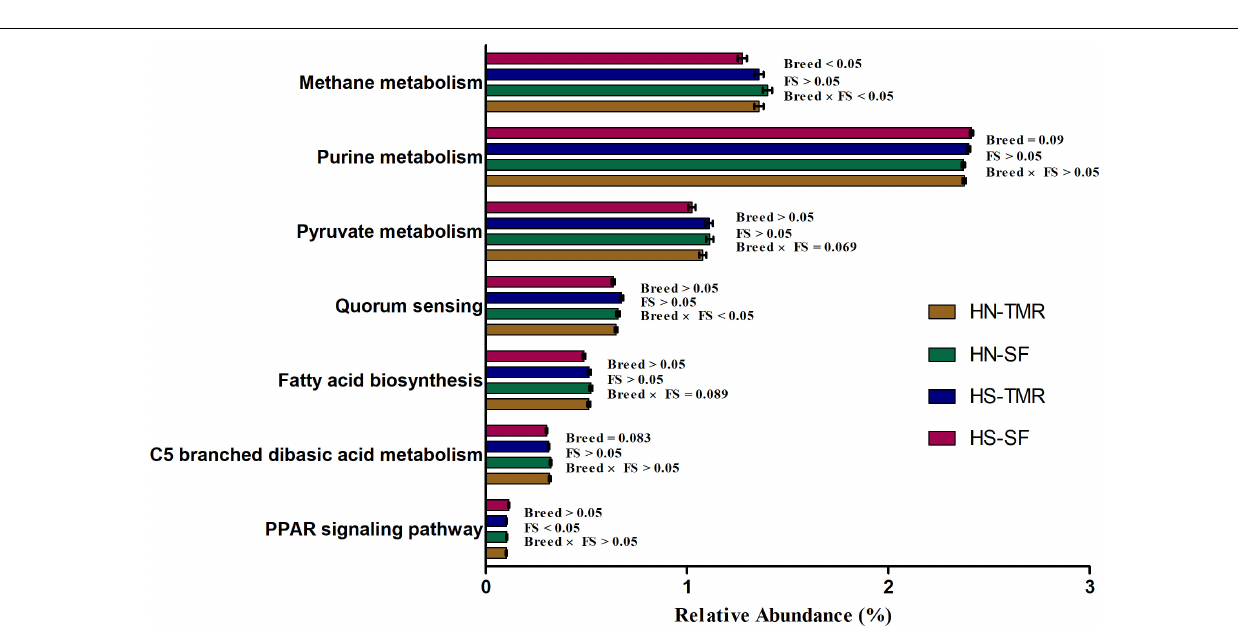
FIGURE 5 | Canonical correspondence analysis (CCA) of microbial functional diversity in the rumen of Hanwoo (HN) and Holstein (HS) steers fed a total mixed ration (TMR) or separate feed (SF) diet.